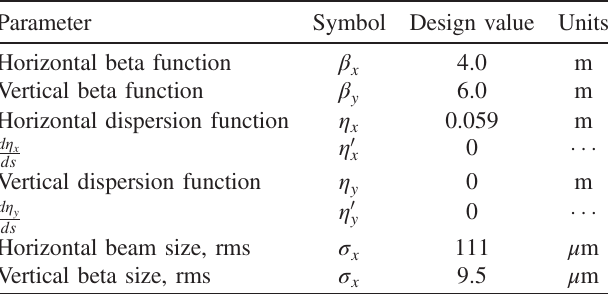
TABLE IV. Lattice parameters at the collimator location in sector 37. Beam sizes are determined using ϵ x ¼ 2 . 58 nm,